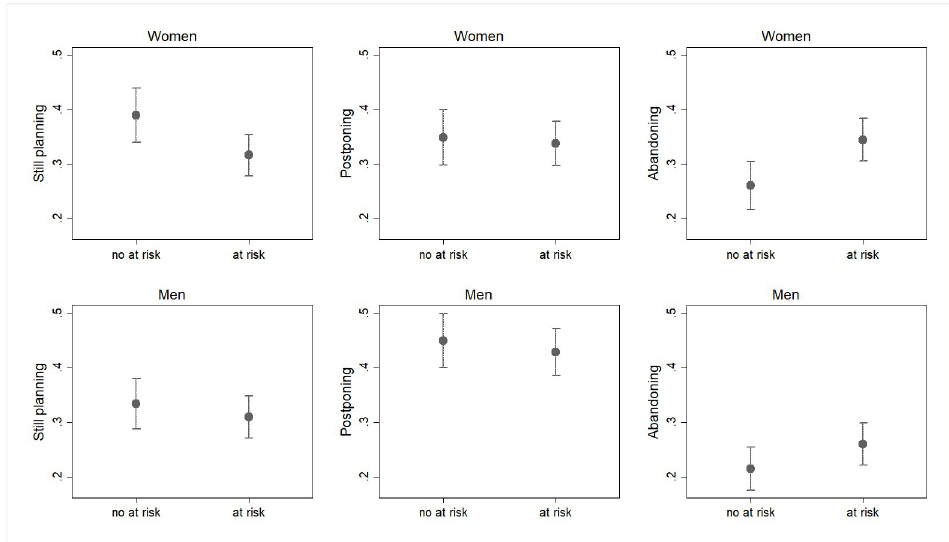
Fig 4. Predicted probabilities of changes or confirmations of pre-COVID fertility plans in March and October 2020 for those who perceived and those who do not perceived their future occupation as at risk (confidence intervals for pair-wise comparisons at the 5% significance level; March and October 2020 waves pooled). Note: Predicted probabilities bases on a multinomial logit model, controlling for age class, education, marital status, presence of children. Full results are available in S1_2 and S1_3 Tables in S1 Appendix. Confidence intervals are calculated to allow for multiple comparisons of predicted probabilities, i.e. to allow testing their statistical equality at an approximate 5% significance level. Overlap between a pair of intervals indicate that the corresponding predicted probabilities are not statistically different at the 10% level, while non-overlap indicate a significant difference. No differences in terms of significancy has been found with confidence intervals at